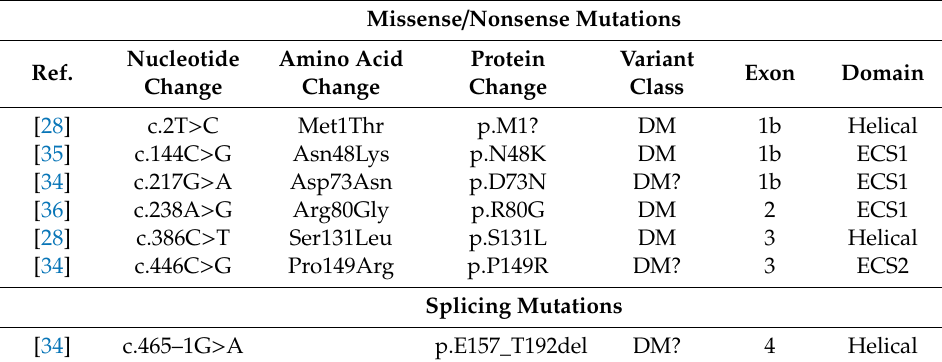
Table 2. CLDN10 disease-causing variants